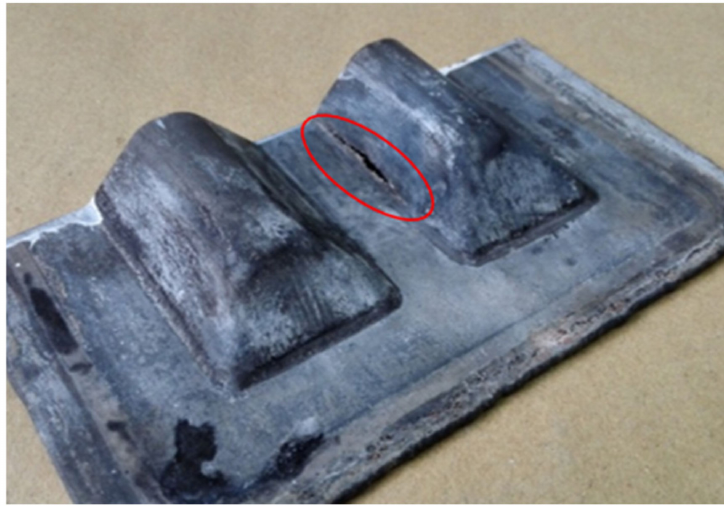
Figure 12. The tearing near the round corner of the forming area.